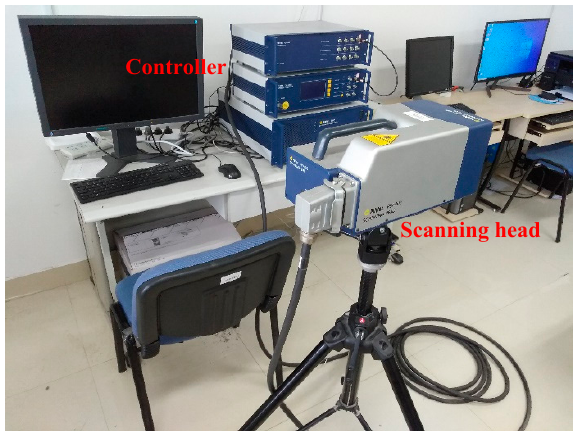
Figure 11. SLV Figure 11. SLV system.